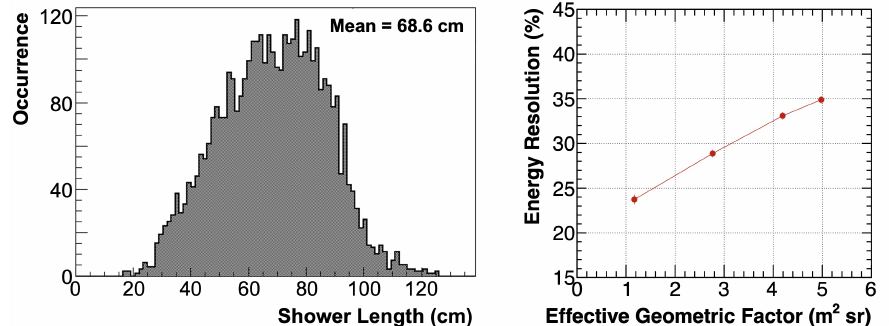
Figure 14. Left: distribution of the shower length in the calorimeter after the point of first hadronic interaction for 1TeV protons impinging isotropically on the calorimeter. Right: depen- dence of the energy resolution for 1TeV protons as a function of the effective geometric factor defined by a selection on the calorimeter fiducial volume and on the particle pathlength inside the calorimeter